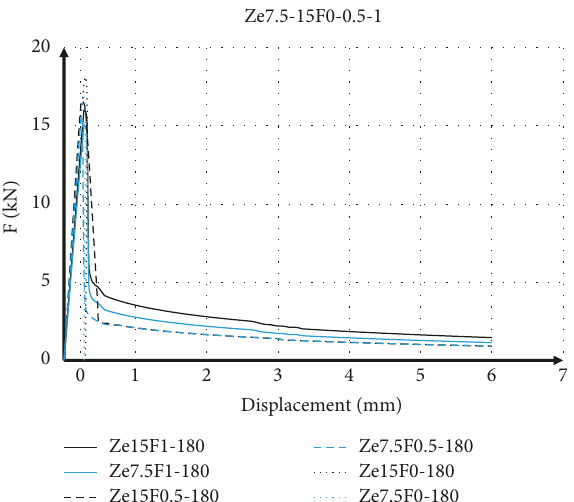
Figure 13: Effect of MPW fiber on flexural behavior of concrete containing zeolite at 180